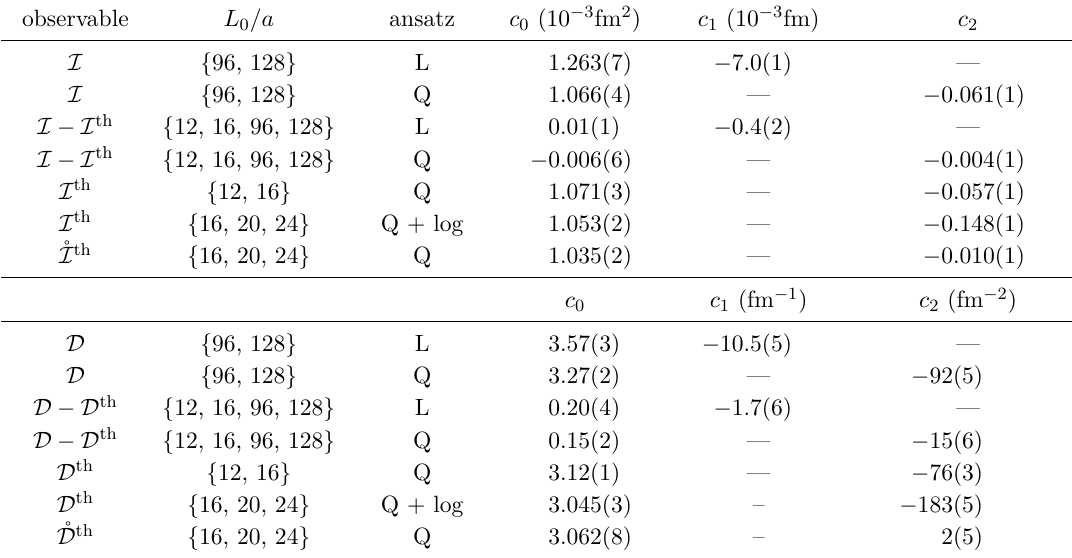
Table 5 . Fit ansätze and results for the N f = 2 observables for the truncated fourth moment of the correlation function with t = 0 . 1974 fm, as well as for the Adler function at Q = 2 . 36